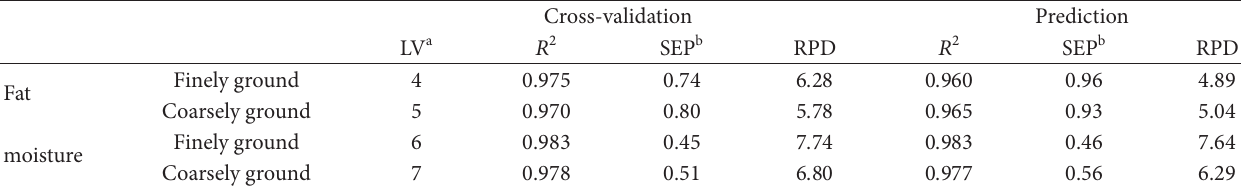
Table 4: Summary of predictability of PLS models for fat and moisture in finely or coarsely ground